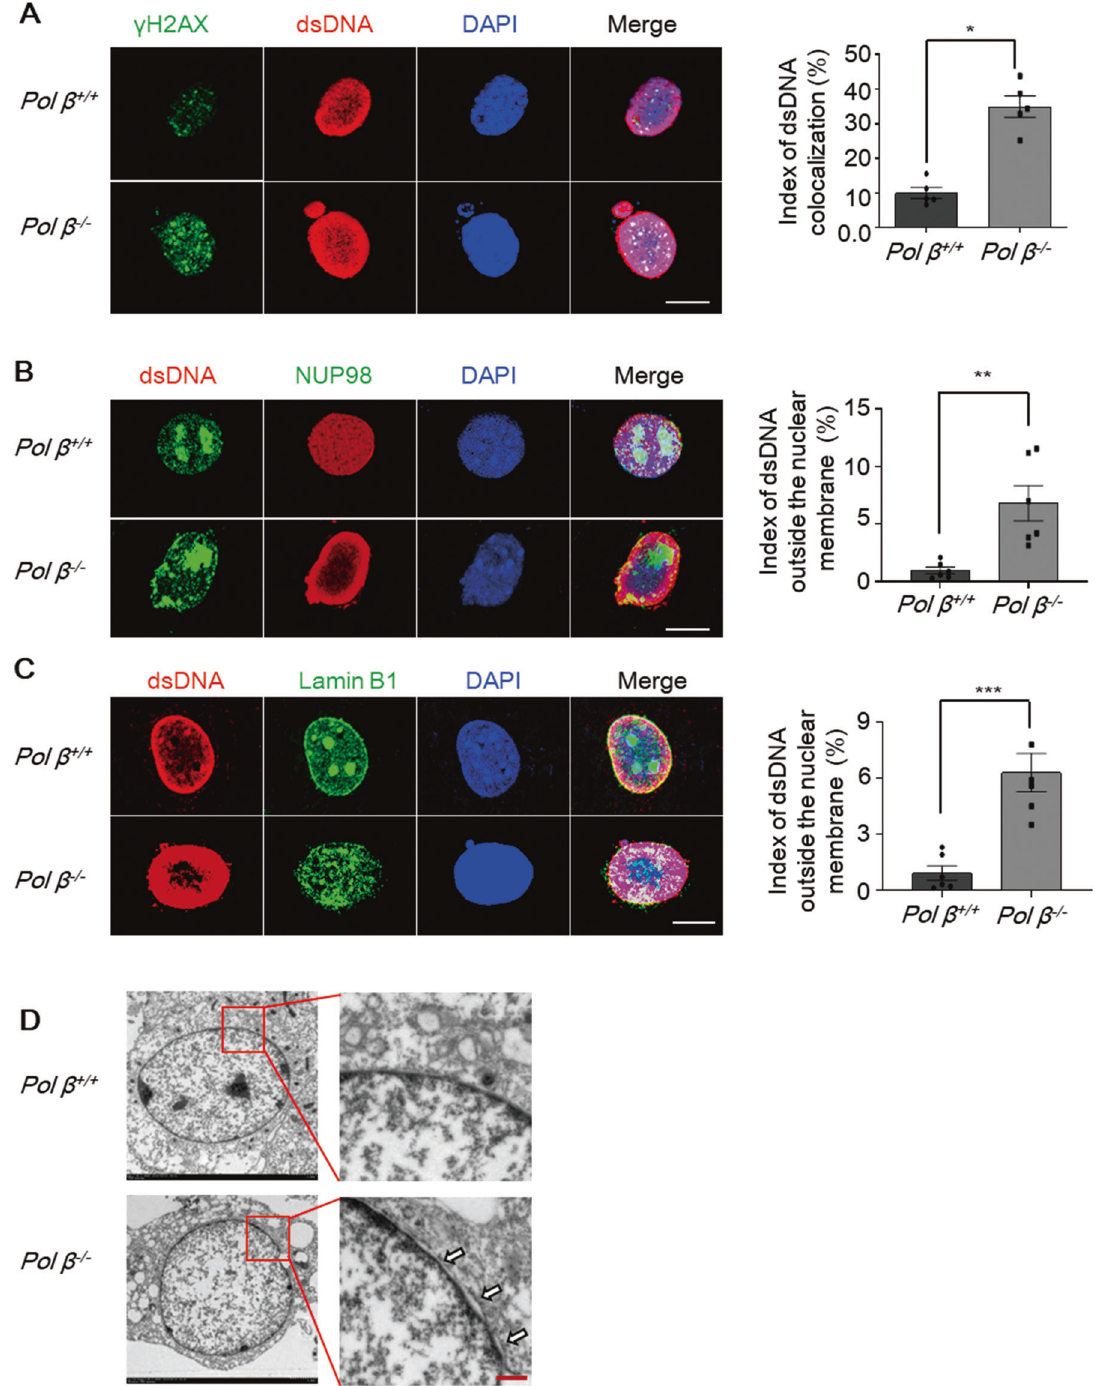
Fig. 5 Export of damaged DNA from the nucleus to the cytosol. Representative confocal immuno fl uorescence images of dsDNA (red) colocalization with γ -H2AX (green) ( A ), NUP-98 (green) ( B ), and Lamin B1 (green) ( C ) in Pol β -knockout MEFs. Colocalization was visualized by using the Image J colocalization fi nder plugin. Colocalization in cells appears yellow in merged images. Right panel: quanti fi cation of the colocalization was performed by using the colocalization function of Image J from 100 cells. Data present mean ± SEM of three independent experiments. Scale bar, 10 μ m. * P < 0.05, ** P < 0.01, *** P < 0.001, Student ’ s t -test. D Abnormal nucleus membrane morphology in Pol β -knockout MEFs was observed by transmission electron microscopy. The White arrowheads indicate the expansion of intramembrous space between inner and outer nuclear membrane. Scale bar, 0.5 μ m. damage in macrophages and MEFs. Moreover, our results suggest lower polymerase activity and an unpaired ability to interact with that the gradual accumulation of DNA lesions leads to cytosolic DNA proliferating cell nuclear antigen (PCNA), resulting in de fi cient DNA leakage because there was increased colocalization of cytosolic repair capacity in reconstitution assays and reduced BER ef fi ciency dsDNA with γ -H2AX (a typical DNA double strand break marker) and [19, 20]. Therefore, in this study, Pol β de fi ciency increased DNA Cell Death and Disease (2022)